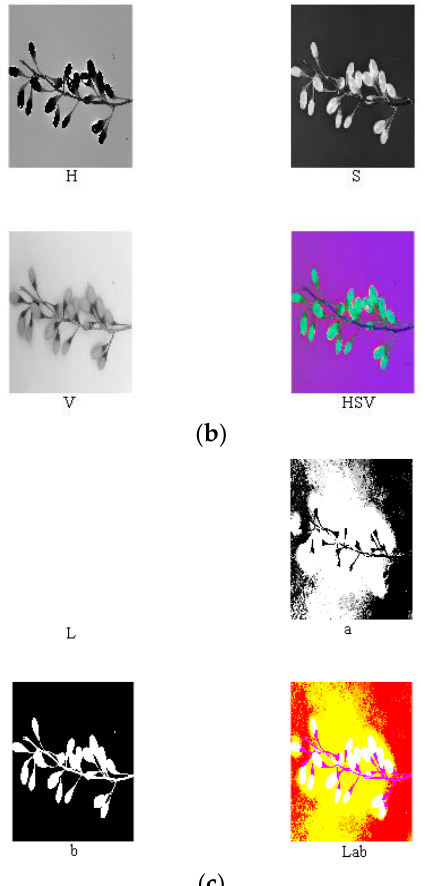
Figure 4. Extraction process of RGB ( a ), HSV ( b ), and lab ( c ) of the ripe fruit.